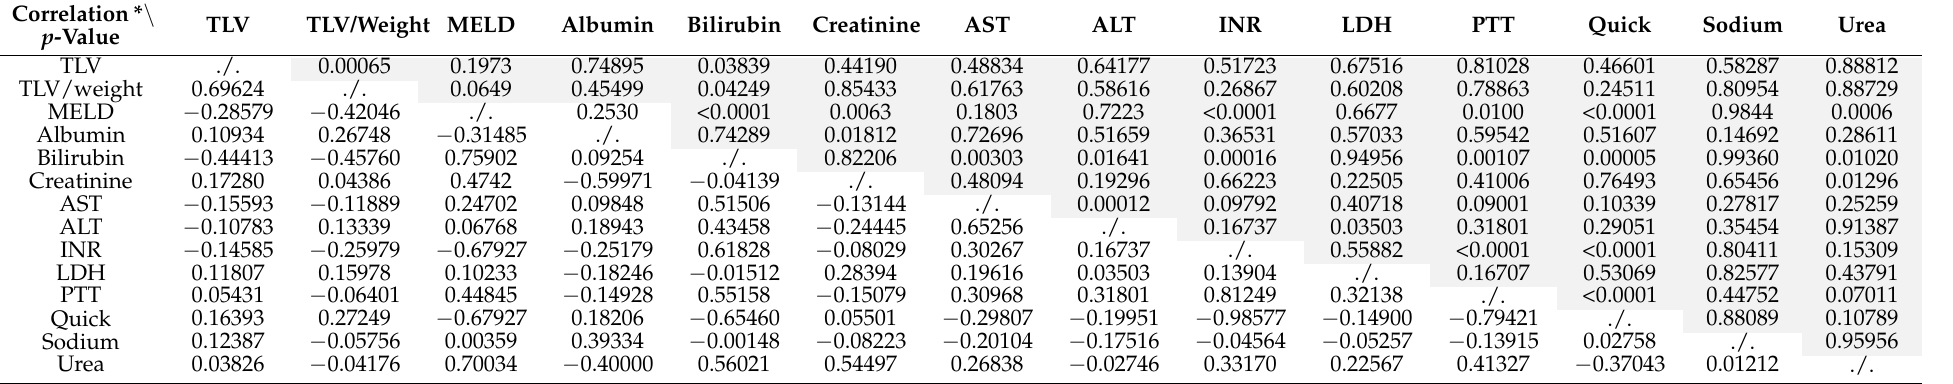
Table 4. Correlation analysis of total liver volume (TLV) and liver function at first follow-up period (FU1: 90–180